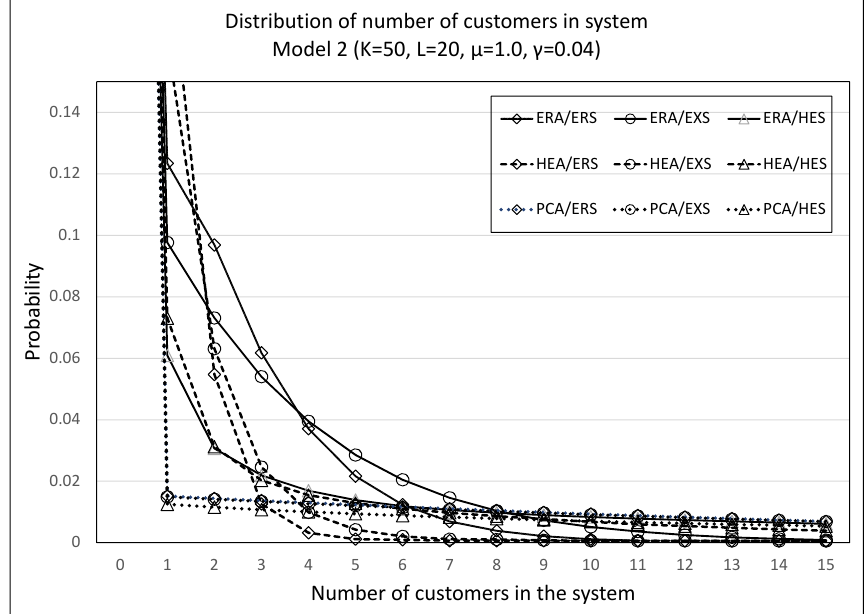
Figure 5. Marginal distributions of number of customers in the system (Model